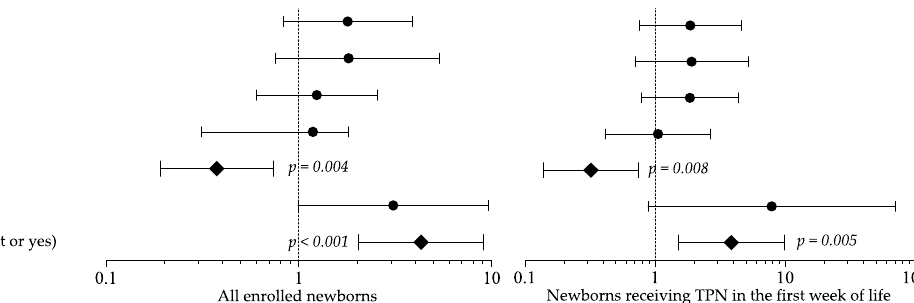
Figure 4. Multivariate analysis to evaluate the influence of covariates on the occurrence of hyperglycemia. Figure legend: CRIB (clinical risk index for babies); EN (enteral nutrition); PN (parenteral nutrition); TPN (total parenteral nutrition).